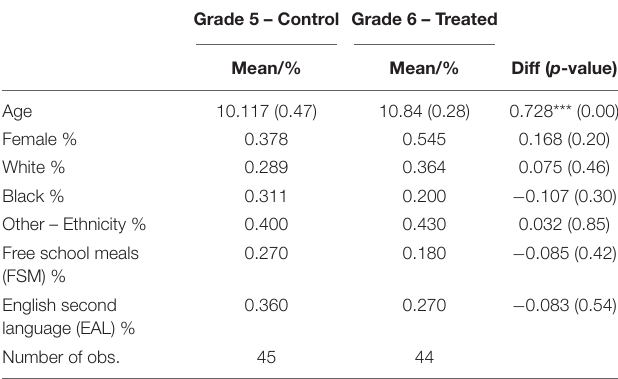
TABLE 1 | Descriptive statistics at baseline, United Kingdom setting.